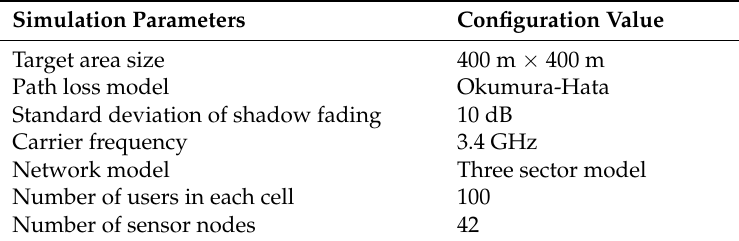
Table 1. Simulation parameter settings.